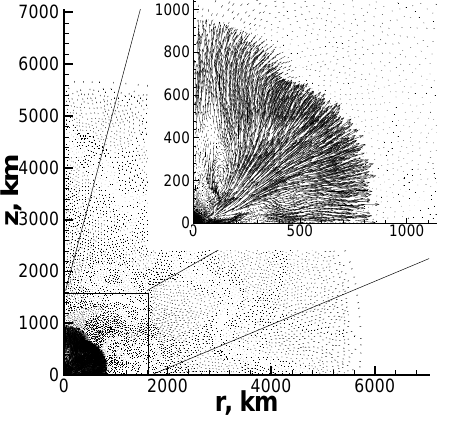
Figure 6: Time evolution of the velocity field (out- flow) for the time moment t = 0 . 075s, from [22]